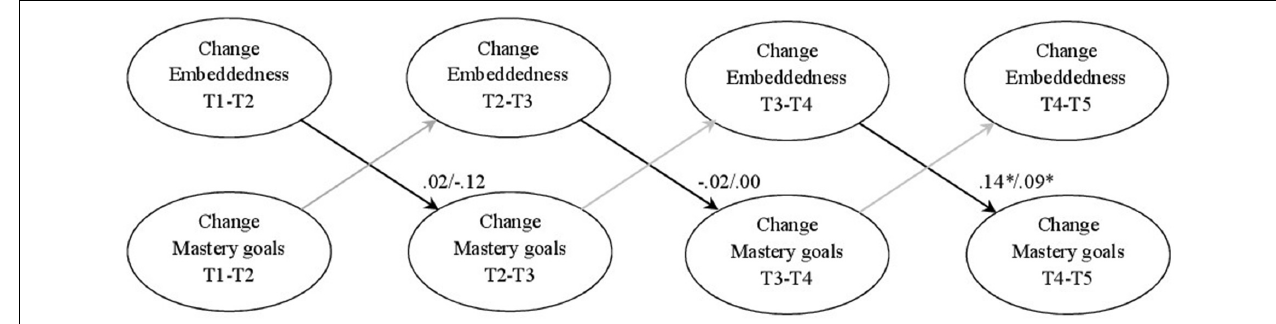
FIGURE 2 | Final true-intraindividual-change model for embeddedness and mastery goals; coefficients (mathematics/English) represent standardized estimates; * p < 0.05, ** p <